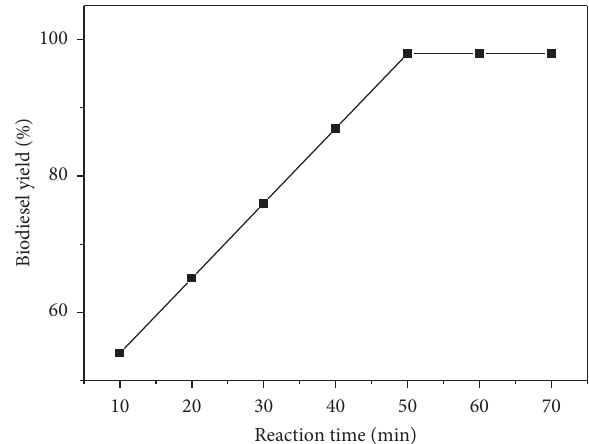
Figure 6: Effect of reaction time on biodiesel yield.